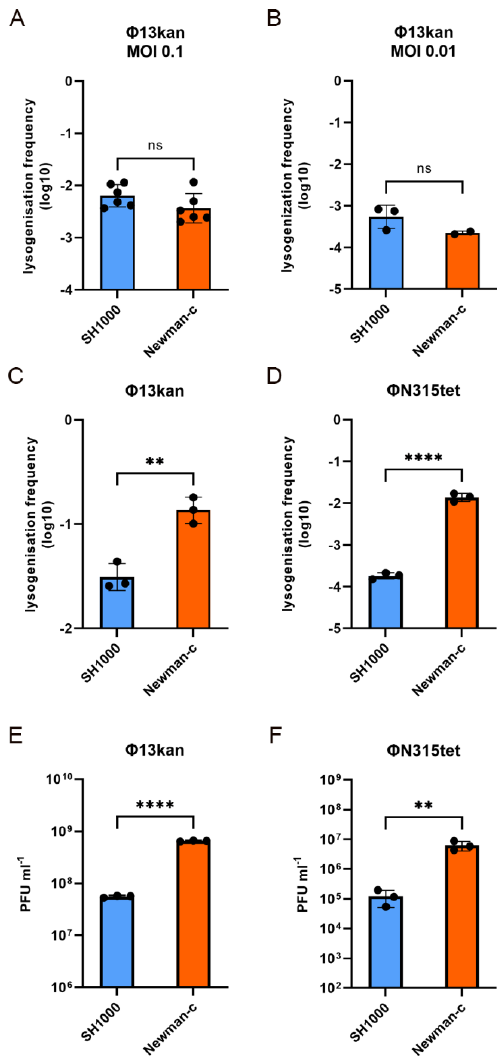
Figure 2. Strain-dependent lysogenization and replication of Ф 13kan and Ф N315tet. Lysogenization of phage-cured SH1000 (blue) and Newman-c (orange) with Ф 13kan ( A – C , E ) or Ф N315-tet ( D , F ) during exponential growth. Phages and phage-cured recipient bacteria were co-cultured to investi- gate lysogenization rates. Co-incubation was performed for 20 min at 37 °C and MOI of 0.1 ( A ) or 0.01 ( B ) or for 4 h at 37 °C and MOI of 0.01 ( C – F ). Lysogenization rates were determined by CFU on TSA plates containing kanamycin or tetracyclin (representing lysogenized colonies)/CFU on blood- agar plates. Replication of Ф 13kan ( E ) and Ф N315tet ( F ) was determined by enumerating phage particles in sterile filtrated supernatant by plaque assay 4 h post phage infection. Values are inde- pendent biological replicates referring to mean ± SD. Statistical analysis was performed using t-test ( A , B ) and one-way ANOVA of log-transformed data ( C – F ). Data are back-transformed for visuali- zation of phage titers ( E , F ). ** p ≤ 0.01, **** p ≤ 0.0001.